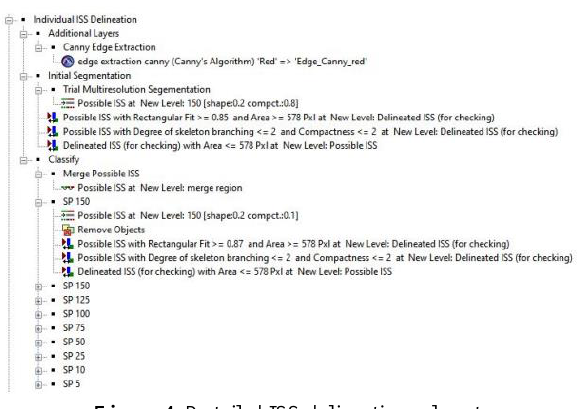
Figure 4. Detailed ISS delineation